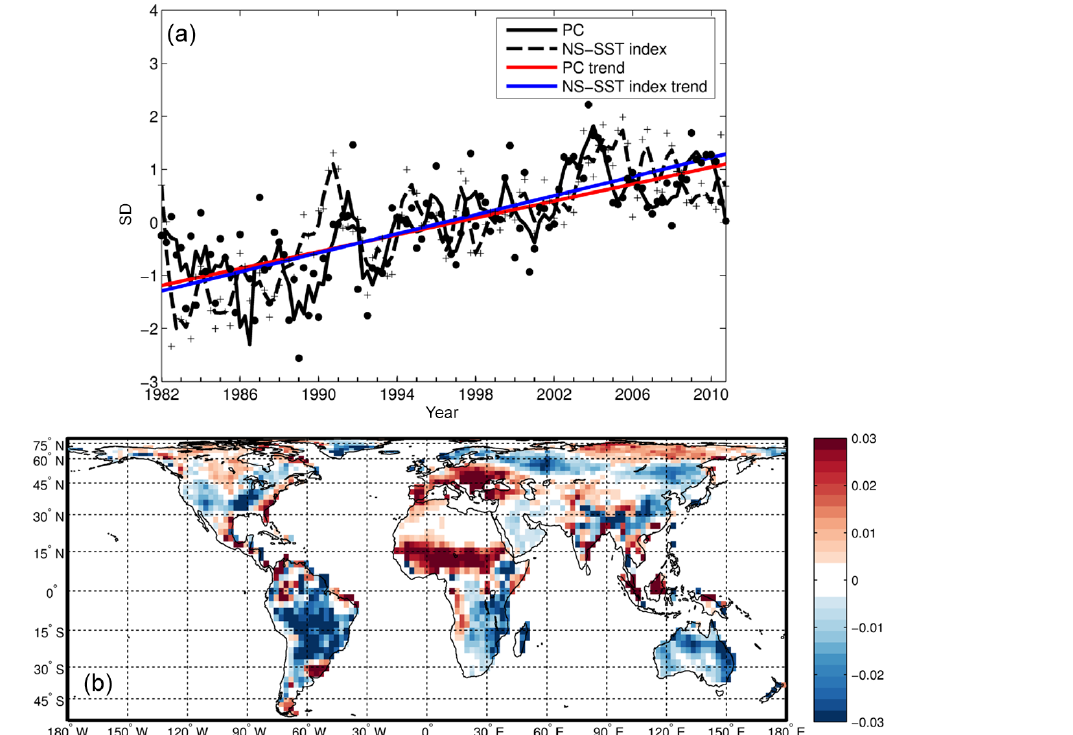
Figure 5. (a) Third normalized PC of the PRE anomalies forced by the SM (full line and filled circles). Dashed line (and cross marks) stands for the normalized NS-SST index. Lines stand for three-season running means, while marks represent each single season. Coloured lines represent the trends (red for the PC, blue for the NS-SST index). (b) Third EOF of the forced PRE. Arbitrary units.